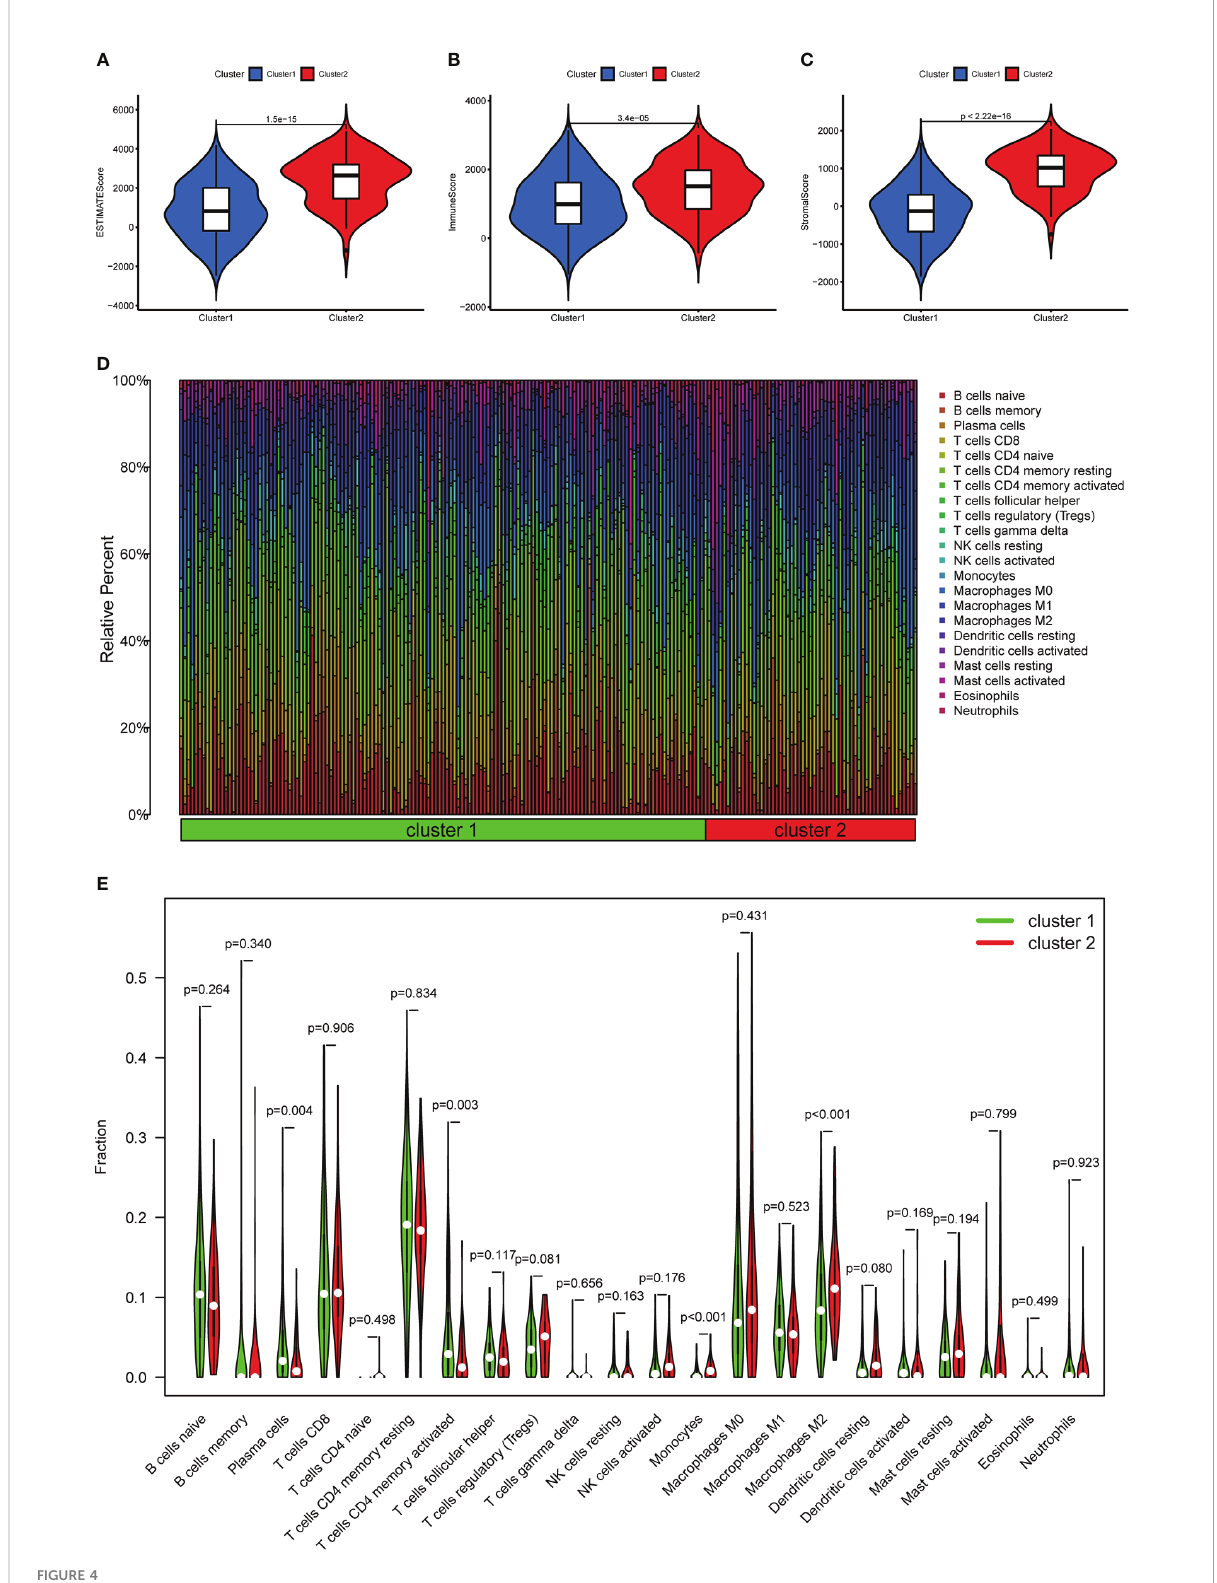
FIGURE 4 The relationship between different clusters and TME. (A – C) Comparison of ESTIMATE scores, Immune scores, and Stromal scores in clusters I and II. (D) The distribution of TIICs in clusters I and II. (E) Violin plot showing differences in TIICs between clusters I and